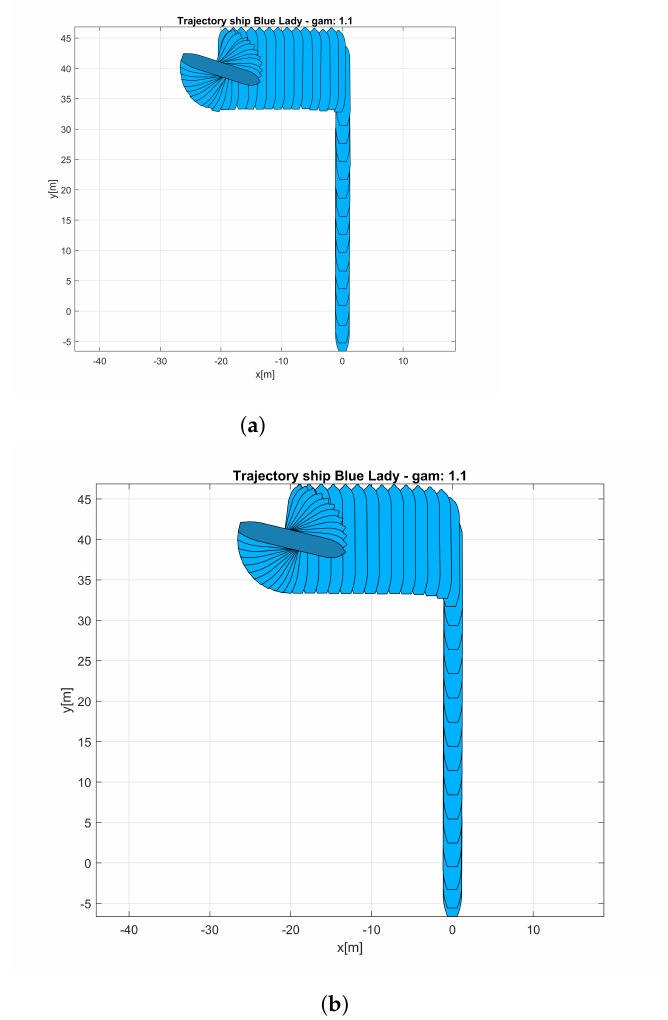
Figure 6. Trajectory of the ship while performing the complex manoeuvre. Initial course of vessel = 0 [deg]. For two Pareto optimal solutions: ( a ) γ ∞ = 1.1, ( b ) γ ∞ =